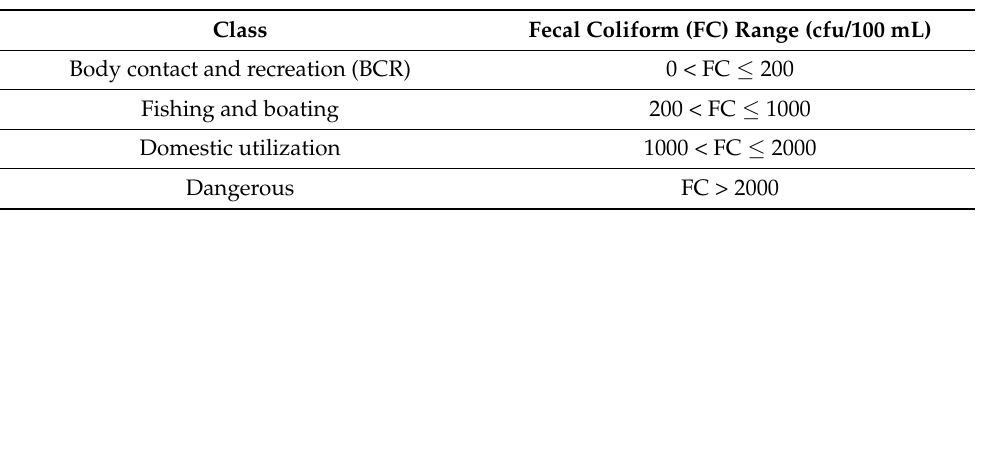
Table 3. Fecal Coliform and its